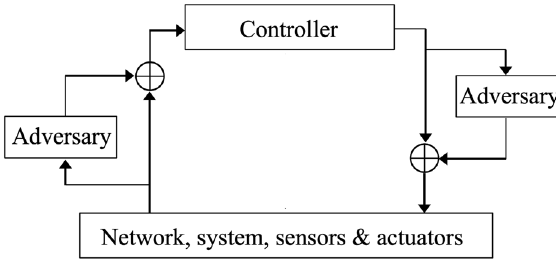
Figure 2. Adversarial model.